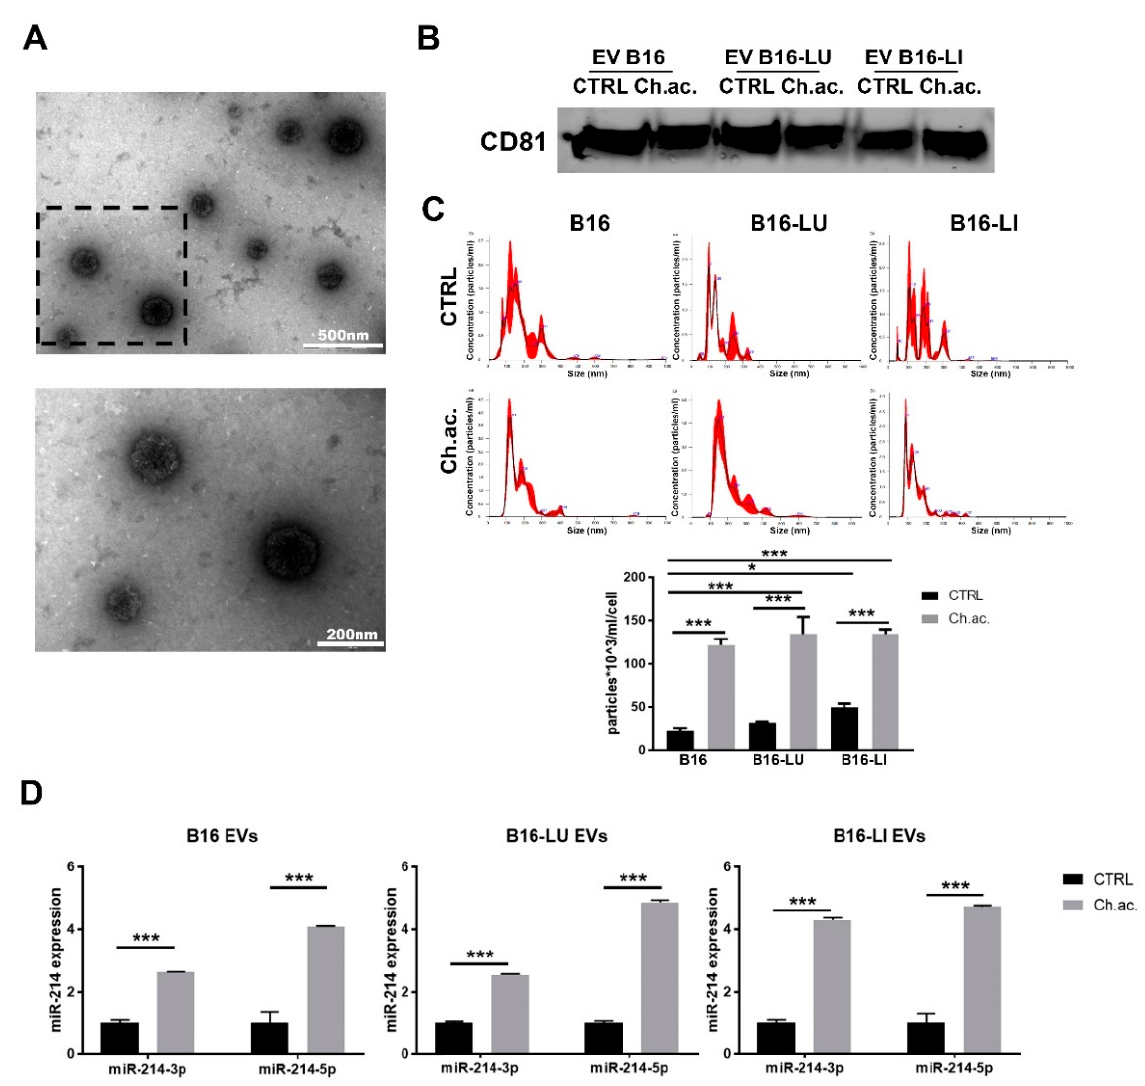
Figure 1. Extracellular vesicles released by melanoma cells. ( A ) Transmission electron microscopy (TEM) of B16-derived EV at different magnifications (upper picture: scale bar = 500 nm; lower picture: scale bar = 200 nm, magnification of the squared area above). ( B ) Western blot analysis of CD81 of melanoma-derived EV. ( C ) Nanoparticle tracking analysis (NTA) at Nanosight NS300 of EV released by B16, B16-LU, and B16-LI cells under standard (CTRL) and chronic extracellular acidosis (Ch.ac.) (one-way ANOVA). ( D ) miR-214-3p and miR-214-5p expression levels in EV released by B16, B16-LU, and B16-LI under standard and chronic acidic conditions (two-way ANOVA). * p < 0.05 and *** p <